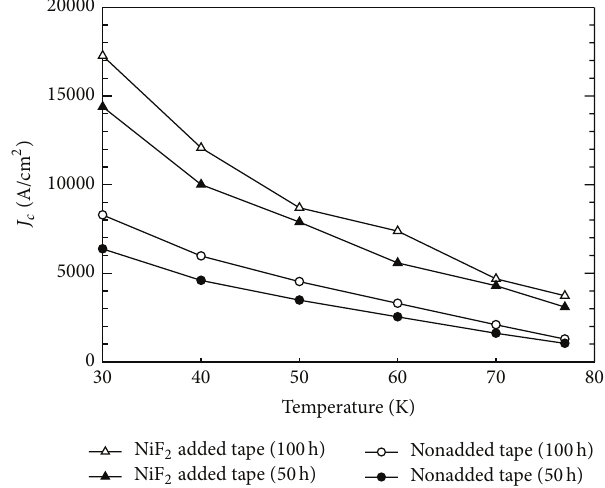
Figure 4: Temperature dependence of critical current density, 𝐽 𝑐 , in zero magnetic fields for nonadded and NiF 2 added Bi-2223 tapes sintered for 50 and 100